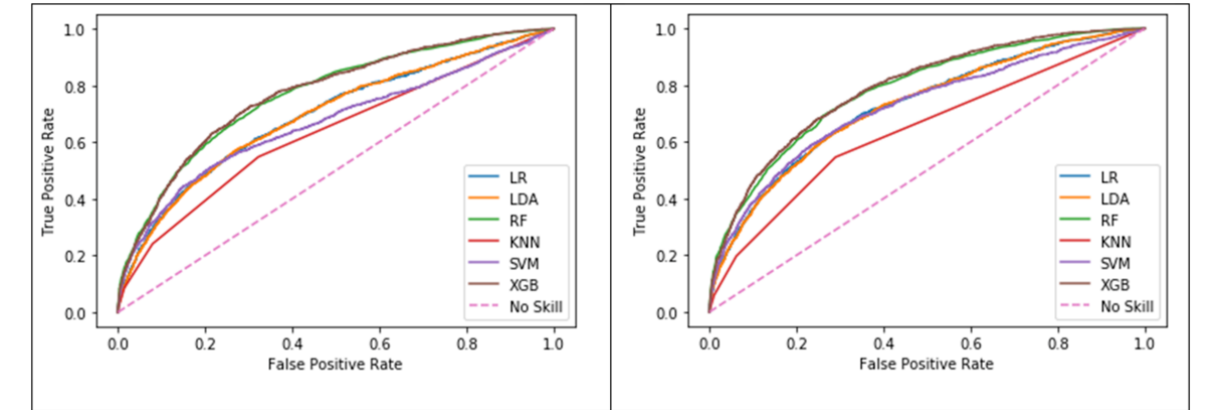
Figure 7. Comparison of receiver operating characteristic curves in the mortality model using the baseline (left) and the quantiles approach (right). LR: logistic regression; LDA: linear discriminant analysis; RF: random forest; KNN: k-nearest neighbour; SVM: support vector machine; XGB: extreme gradient boosting.